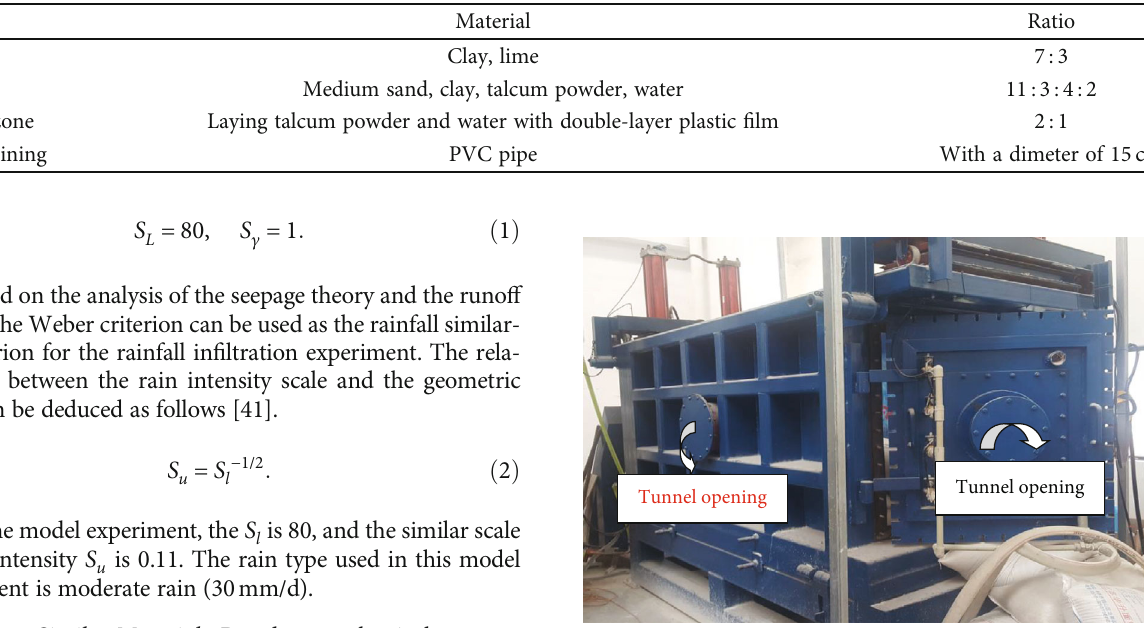
Figure 1: The model box [42].